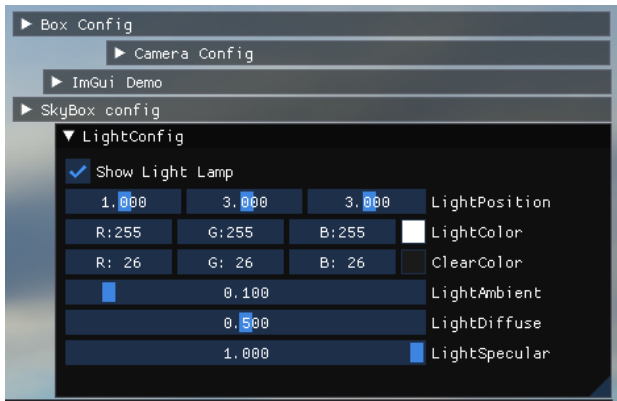
Figure 10. The UI (user interface) windows for physics, audio, and DNN modules, respectively.